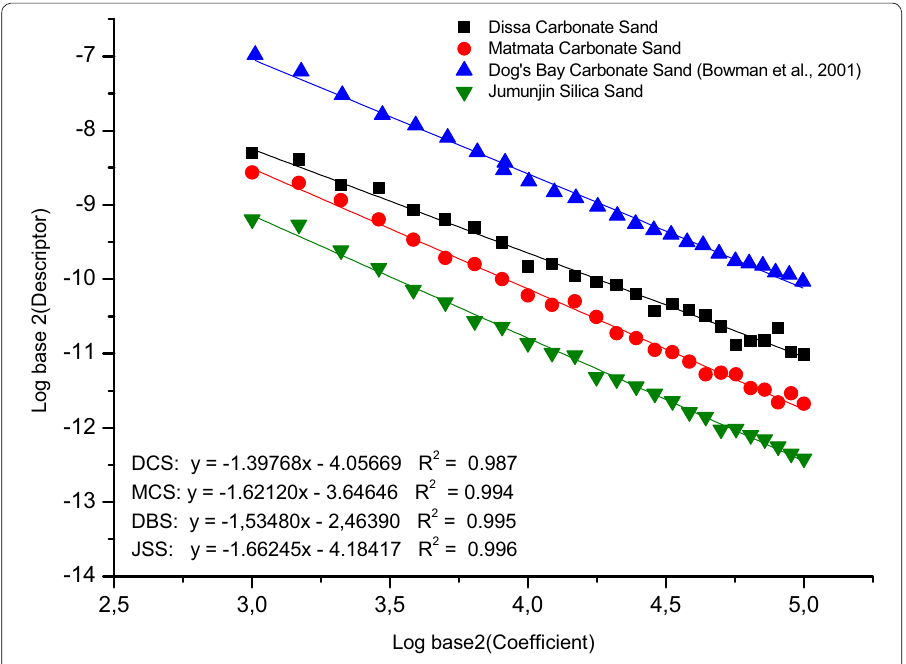
Fig. 13 Log/Log plot to base 2 of higher descriptors for Dissa sand, Matmata sand, Dog’s Bay carbonate sand (from Bowman et al. [5]) and Jumunjin silica